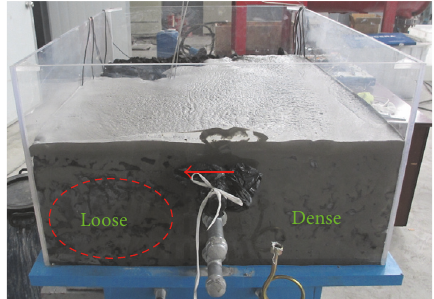
Figure 8: Penetration and diffusion form of the foam fluid in the 𝑌 - 𝑍